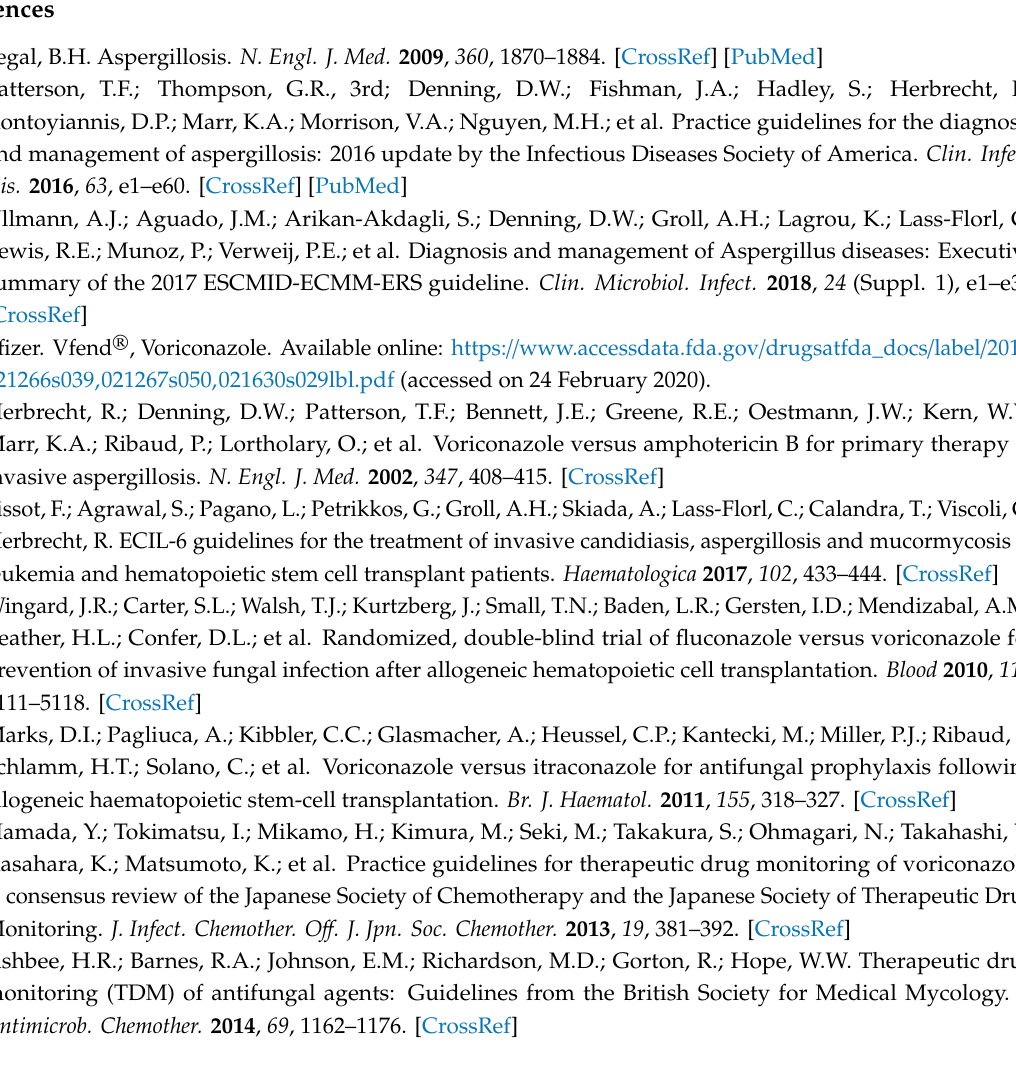
Figure S1: A visual predictive checks (VPC) plot of the final model. Open circles show observed plasma concentrations, and the solid line and dashed line show the median and 95% confidence interval (CI) of observations, respectively. The red shaded area and the blue shaded area show the 95% CI of the median and the 5th and 95th percentiles of the consequence of 1000 simulations of the final model, respectively, S1: Code of the one-compartment model, S2: Patients with body weight < 40 kg, Table S1: The sensitivity analysis results by base model showed that the clearance estimates were consistent across di ff erent values of the absorption rate constant (Ka)